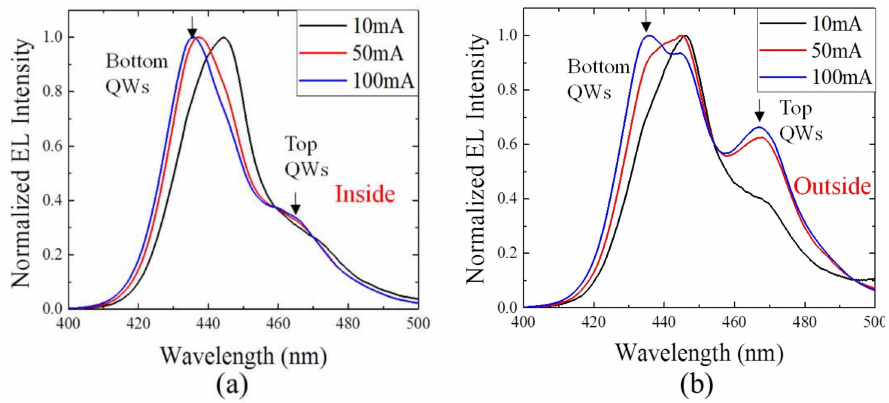
Figure 5. NSOM-ELspectraofarea( a )insideand( b )outsideofaV-defectat10,